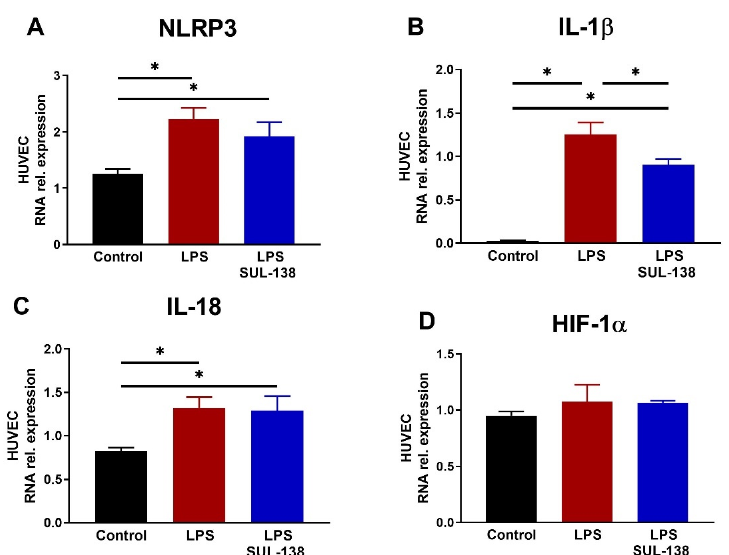
Figure 2. Sul-138 did not affect LPS increased transcription of inflammatory markers in HUVECs. HUVECs were pre-incubated with SUL-138 (10 µ M) for 10 min, followed by incubation with LPS (10 µ g/mL) for 24 h (n = 8). ( A ) LPS increased NLRP3 RNA expression levels, which was unaffected by SUL-138. ( B ) LPS increased IL-1 β RNA expression levels, which was limited in the presence of SUL-138. ( C ) LPS increased IL-18 RNA expression levels, which were similar in the presence of SUL-138. ( D ) HIF-1 α RNA expression levels were similar in all groups. Data are represented as mean ± SEM, * p < 0.05. HUVECs, human umbilical vein endothelial cells; LPS, lipopolysaccharide.